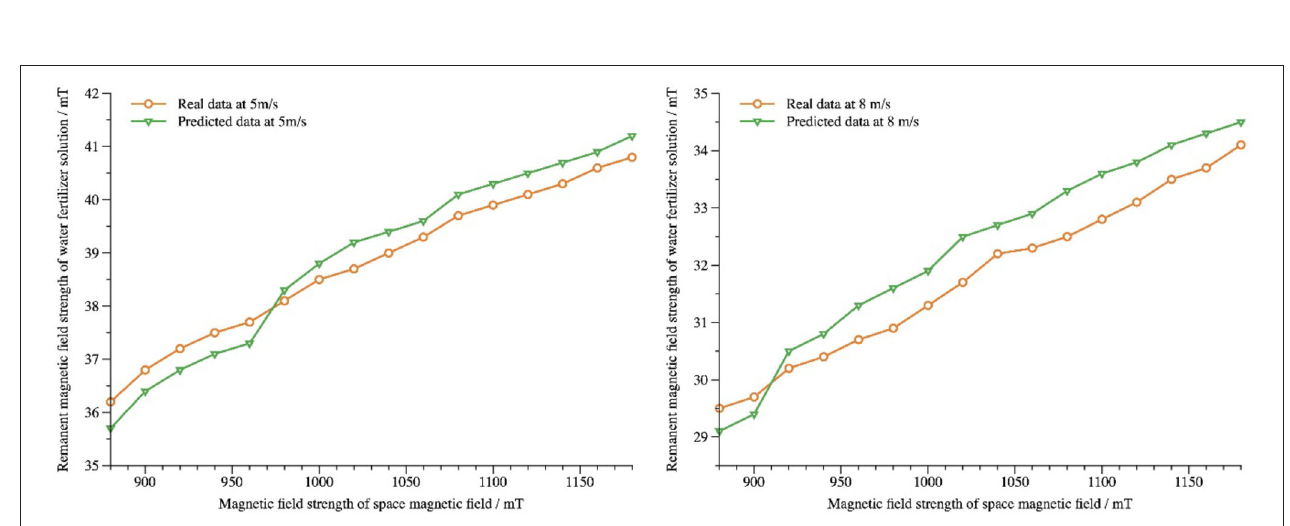
FIGURE 7 | Comparison of predicted data with real detection data.